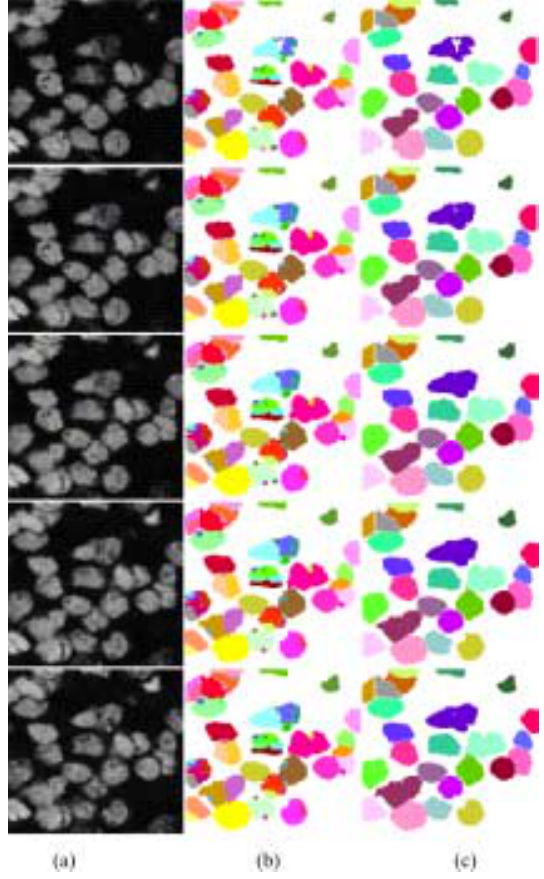
Fig. 1. (a) Sequence of image slices, (b) isolation of regions by sim- ple watershed, (c) after identifying the fragments and merging them to parent cell. This figure can be viewed in colour on http://www.